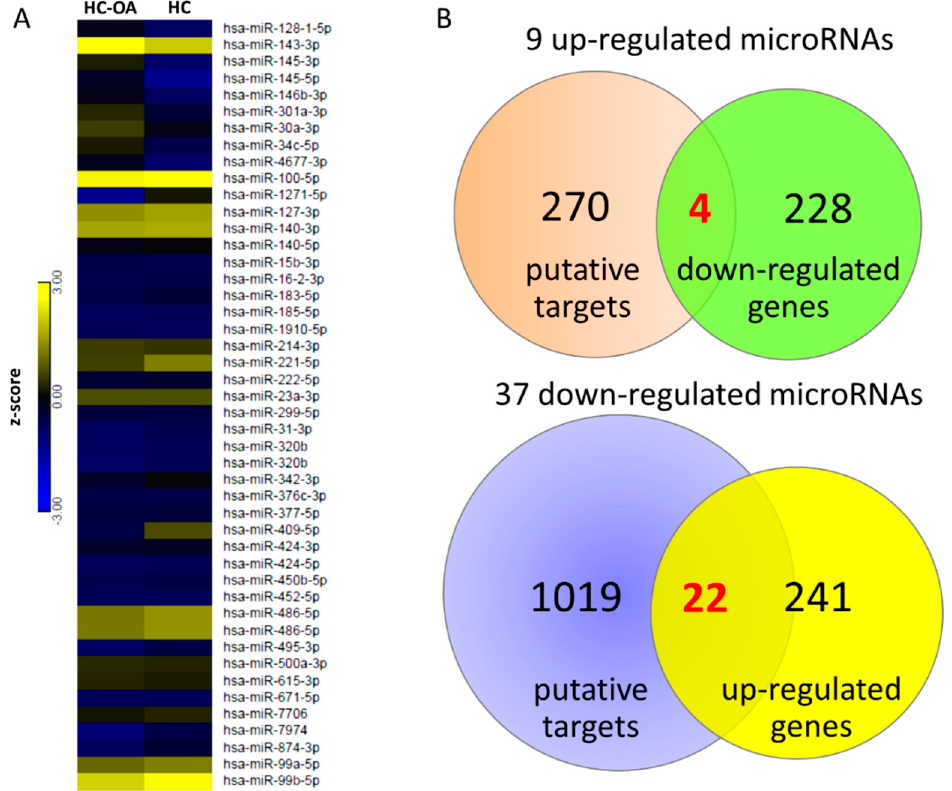
Figure 5. Identification of dysregulated miRNAs and potential miRNA–mRNA interactions in OA knee chondrocytes. ( A ) The 46 differentially expressed miRNAs of OA chondrocytes (>2.0-fold change and reads per million (RPM) > 10) were identified from the next-generation sequencing (NGS) result, and the heat map with z-score values is shown. ( B ) The miRmap database analysis identified 274 putative targets of nine up-regulated miRNAs and 1041 putative targets of 37 down-regulated miRNAs (selection threshold set at miRmap score ≥ 99.0). In addition, 232 down-regulated genes and 263 up-regulated genes (>2.0-fold change and fragments per kilobase of transcript per million (FPKM) > 0.3) in OA chondrocytes were identified from the NGS results. The putative targets of up-regulated (down-regulated) miRNAs were matched to our down-regulated (up-regulated) protein-coding genes using the Venn diagram analysis, which yielded four down-regulated genes and 22 up-regulated genes with potential miRNA–mRNA interactions in OA knee chondrocytes.